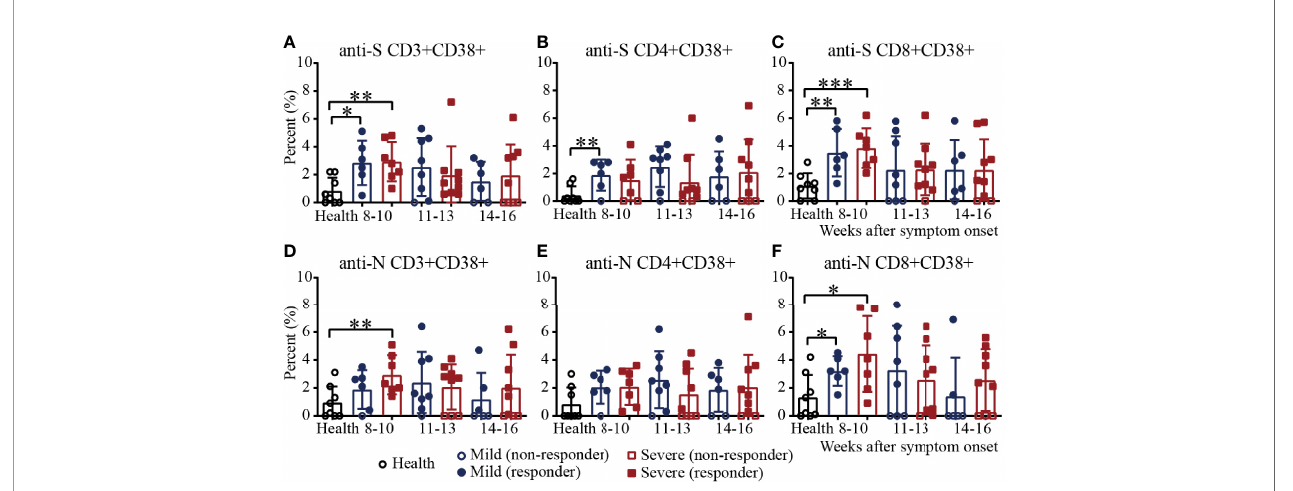
FIGURE 4 | Activation of T cells against the SARS-CoV-2 S/N protein peptide pool in recovered COVID-19 patients. Comparison of the CD3 + CD38 + (A) , CD4 + CD38 + (B) or CD8 + CD38 + (C) S protein peptide pool or the CD3 + CD38 + (D) , CD4 + CD38 + (E) or CD8 + CD38 + (F) N protein peptide pool between the mild and severe patients from 8 to 16 weeks after symptom onset (Health, n=8; patient, n=22). *P<0.05; **P<0.01; ***P<0.001.